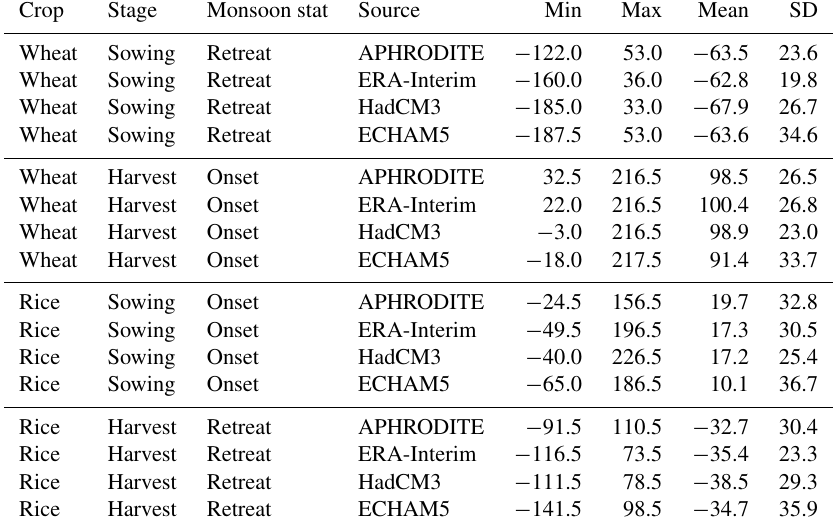
Table 2. Analysis of the differences between the midpoints of the MinAg data and monsoon onset and retreat for rice and wheat sowing or harvest dates: the table shows the minimum, maximum, mean, and standard deviation (SD) averaged across South Asia where wheat or rice is